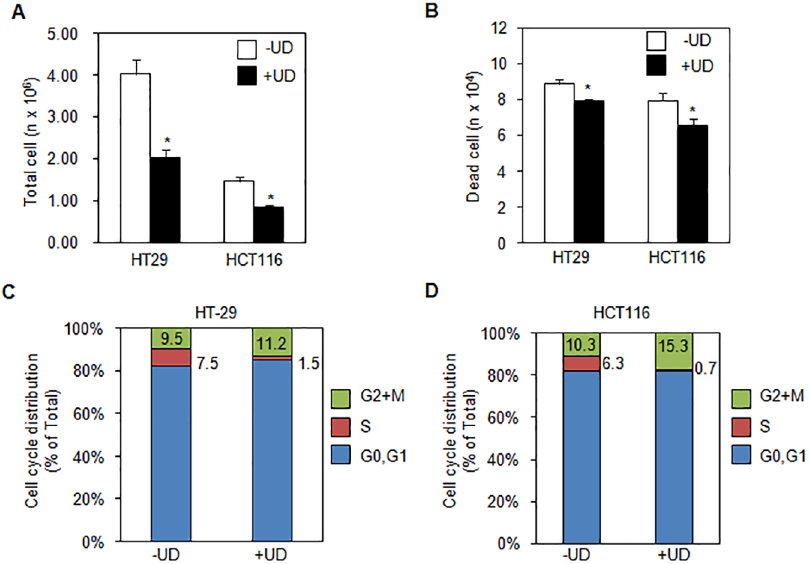
Fig 1. Ursodeoxycholic acid(UDCA)inhibited proliferation by cell cycle arrestin colon cancer cells. (A) Total cell numberof HT29 or HCT116 reducedby treatment of 0.2 mM UDCA for 48h. (B) Dead cell countingof HT29 or HCT116 decreased by exposureto 0.2 mM UDCA at 48h. (C) S phase was decreased after treatment of 0.2 mM UDCA stainedwith BrdU and determined by flow cytometry. Asterisks indicate statistical significance(t <